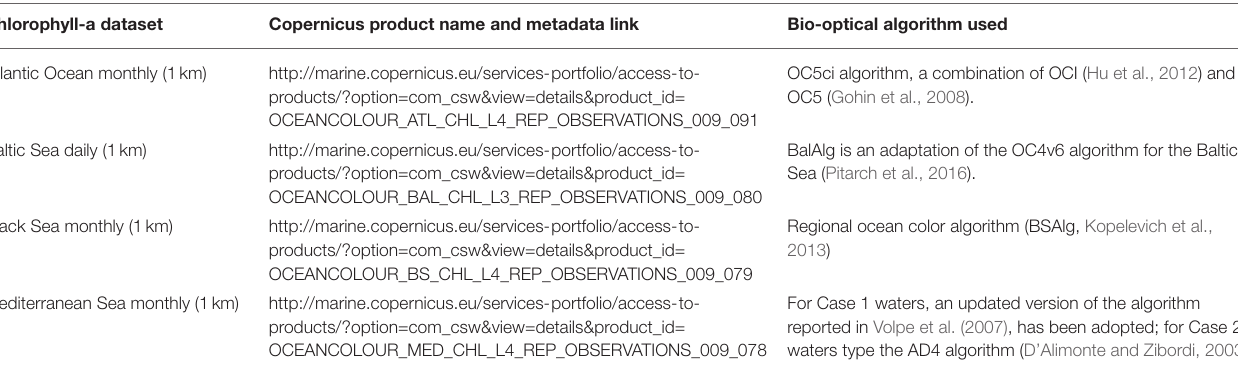
TABLE 1 | Copernicus marine products from which satellite chlorophyll-a data were extracted. Chlorophyll-a